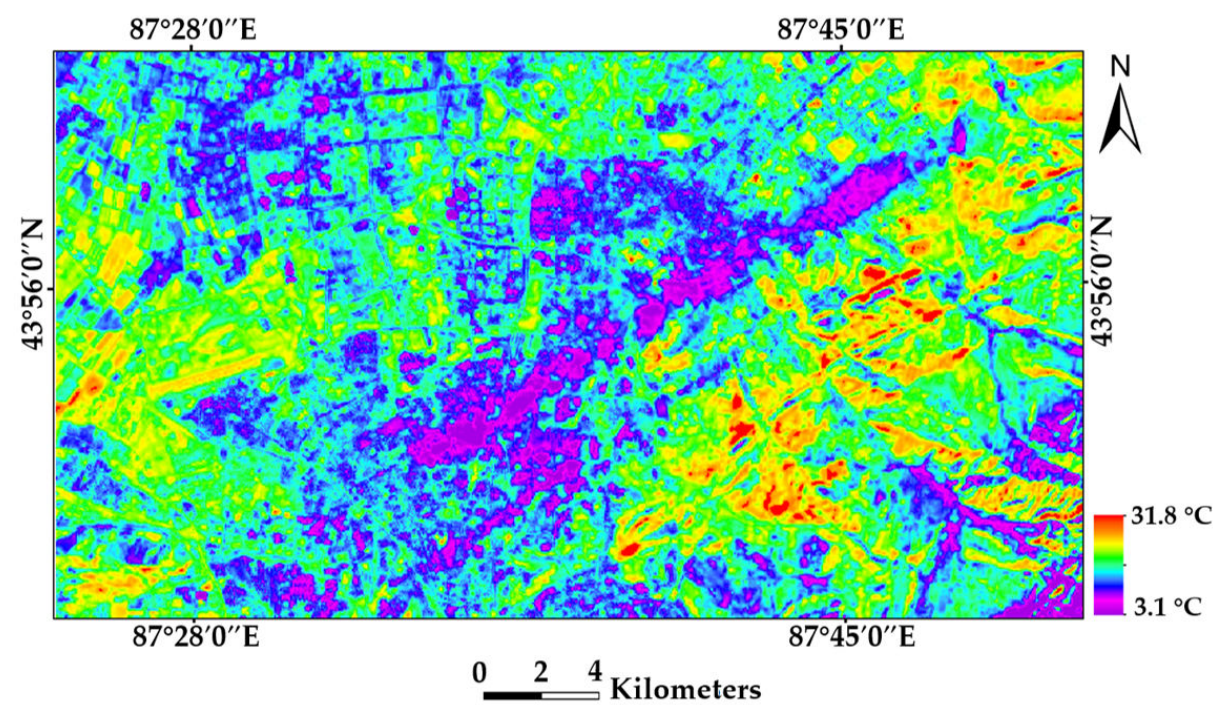
Figure 4. Result of LST inversion based on a Landsat-8